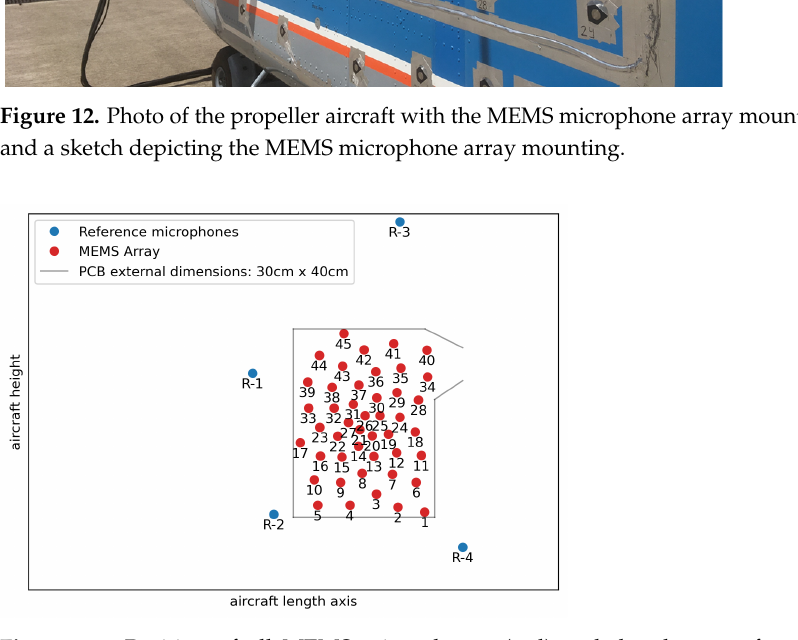
Figure 13. Position of all MEMS microphones (red) and the chosen reference surface micro- phones